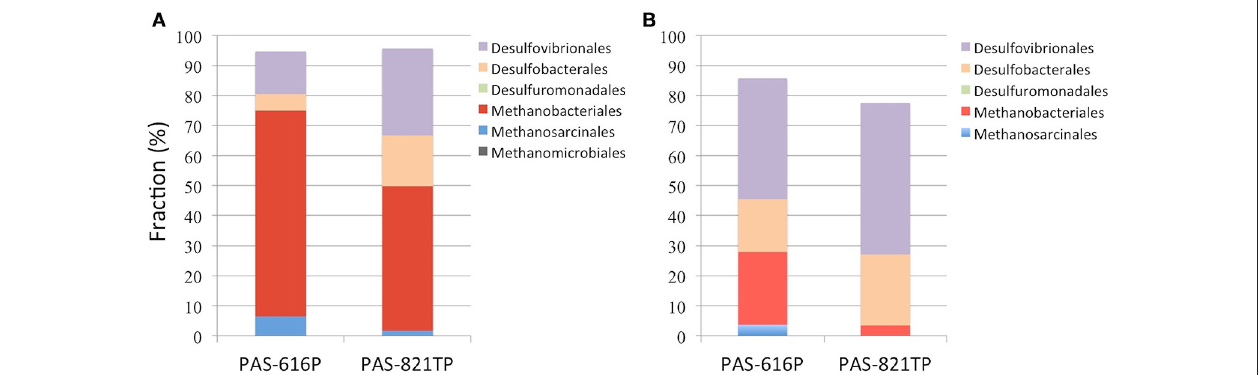
FIGURE 1 | Order-level composition of Archaea and Deltaproteobacteria derived from (A) 16S amplicons and (B) 16S sequences of 454 metagenomes. The deltaproteobacterial orders Myxococcales and Syntrophobacterales are not obvious due to their low abundance in both libraries. The increased fractions of archaeal orders in (A) are likely caused by PCR bias.